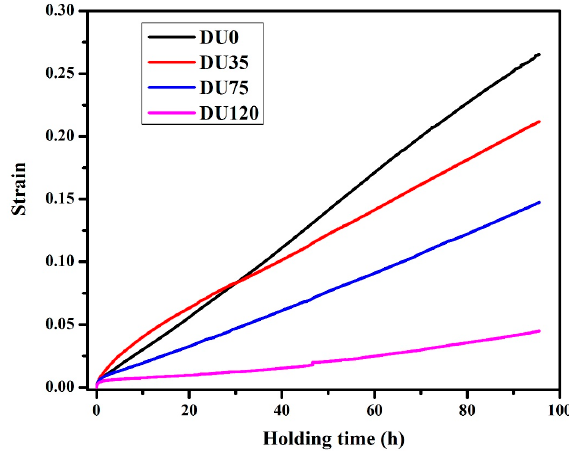
Figure 16. Typical creep curves of four experimental alloys, tested at 300 °C with a constant load of 58 MPa.